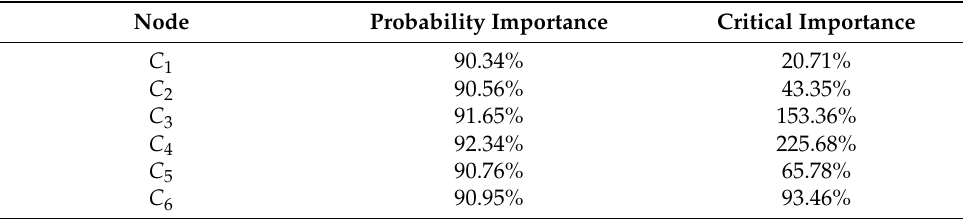
Figure 6. Analysis diagram of catenary construction risks Bayesian network reverse inference. Table 11. Critical importance calculation results of probability